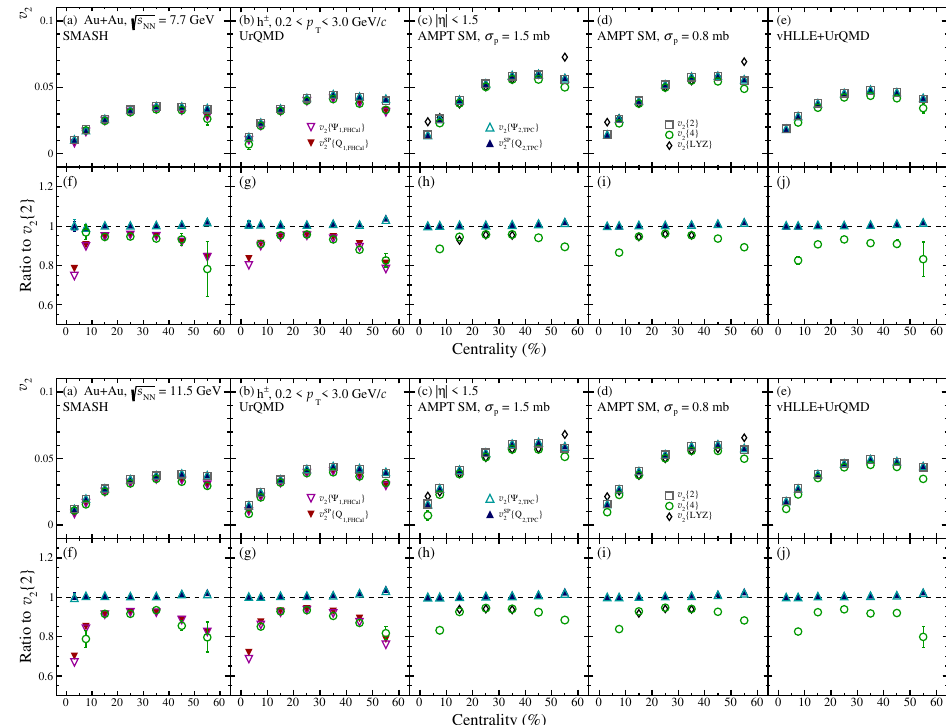
Figure 4. Centrality dependence of v 2 of inclusive charged hadrons from Au+Au collisions at √ s NN = 7.7 and 11.5 GeV measured by different methods. Panels ( a – e ) correspond to different models. Panels ( f – j ) show the v 2 { method } / v 2 { 2 } ratio.